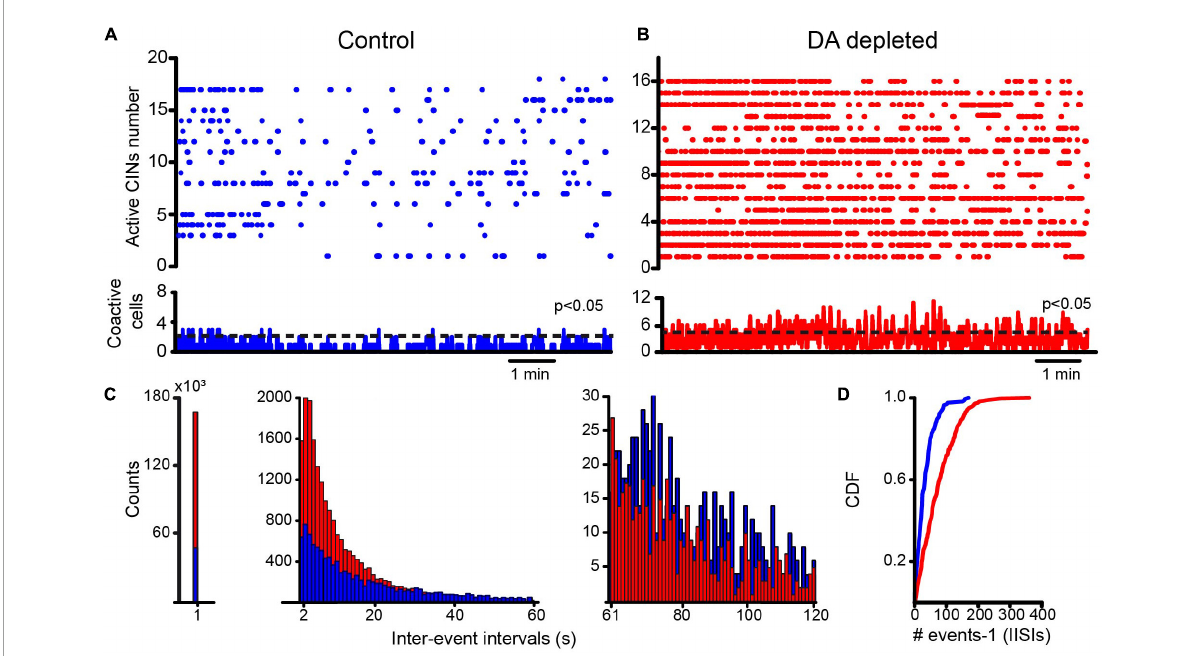
FIGURE6 Striatal cholinergic interneurons increase their activity as shown by raster density and modify their firing pattern after DA depletion. (A) The raster plot showing the activity of several identified CINs in a brain slice in control conditions. A few significant coactivity peaks have 3 or fewer neurons. (B) The raster plot shows the activity of several identified CINs in DA-depleted conditions; augmented firing is clear during the simultaneous recording of CINs. Several significant coactivity peaks along time have 6 or more neurons (P = 0.05 after Monte Carlo simulations; see Pérez-Ortega et al., 2016). (C) The distribution of all inter-event intervals illustrates differences in raster plot density in both conditions (an event—a dot—denotes neural activity; an inter-event interval is silence between events). The distribution is skewed and has to be shown at different scales. The left histogram shows intervals of < 1 s showing that DA-depleted CINs activate more frequently. The middle histogram shows more prolonged events < 60 s. DA-depleted CINs have more events of this type since activity trains are followed or preceded by pauses. The right histogram shows that more prolonged intervals of < 120 s belong to CINs in control conditions. (D) Lumped and normalized as cumulative distribution functions (CDFs) of all inferred interspike intervals (IISIs), counting all intervals for each condition, show significant differences ( P < 0.0001; control, n = 163 cells from n = 10 slices from 10 different animals; DA-depleted CINs, n = 285 cells from n = 13 slices from 12 different animals; Kolmogorov-Smirnov test). DA-depleted CINs appear to fire in trains with pauses exhibiting a higher density in the raster